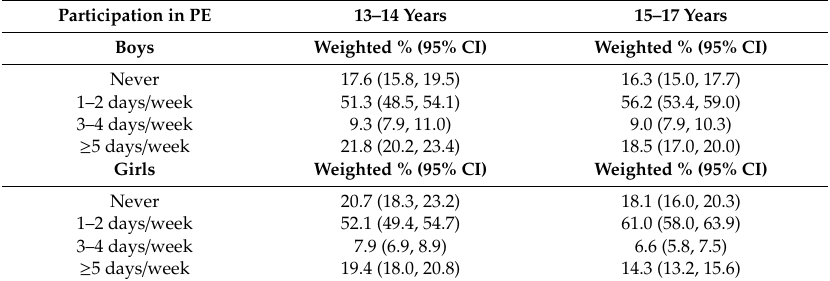
Table 2. Participation in physical education classes according to age, stratified by sex.